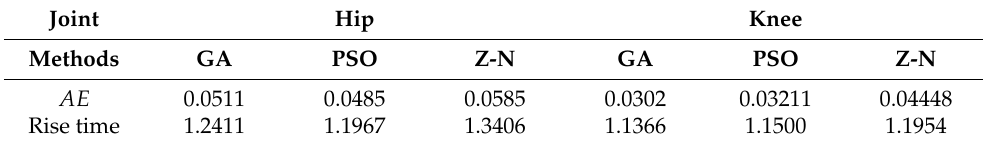
Table 5. Error and rise time for step response.